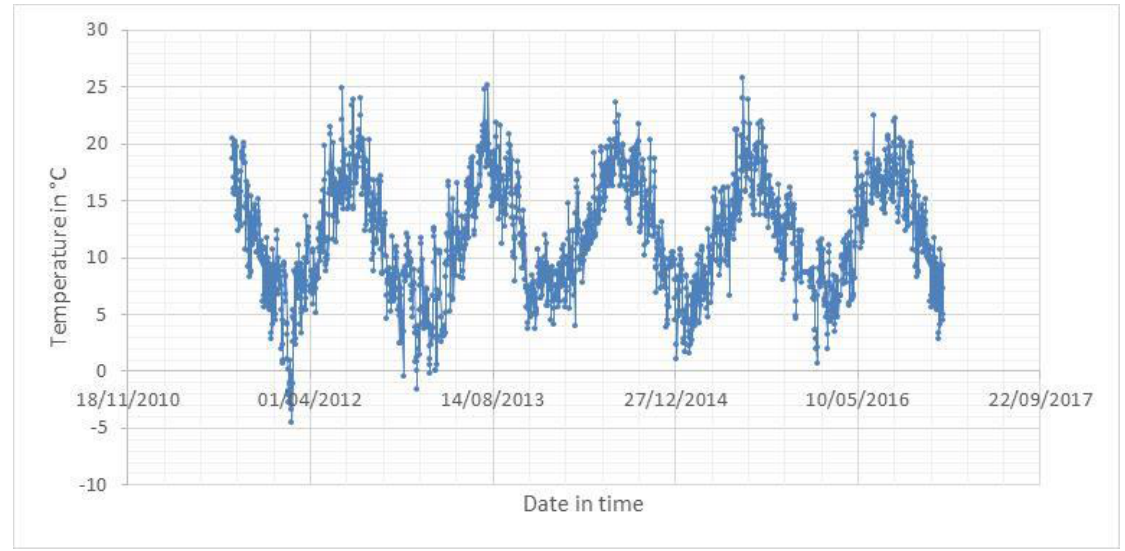
Figure 5. Daily evolution of the ambient air temperature during five seasons.